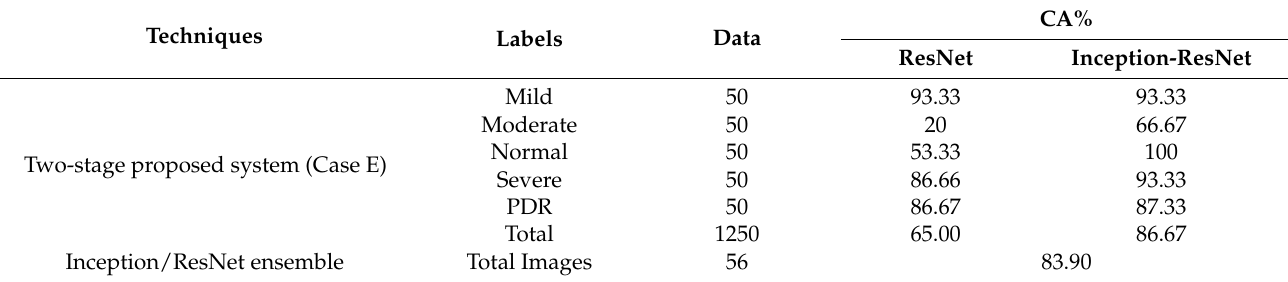
Table 3. Results comparison between associated techniques ([10], 2018) for 5-stage DR classification and the suggested 2-phase model with the help of Inception-ResNet relating neural network